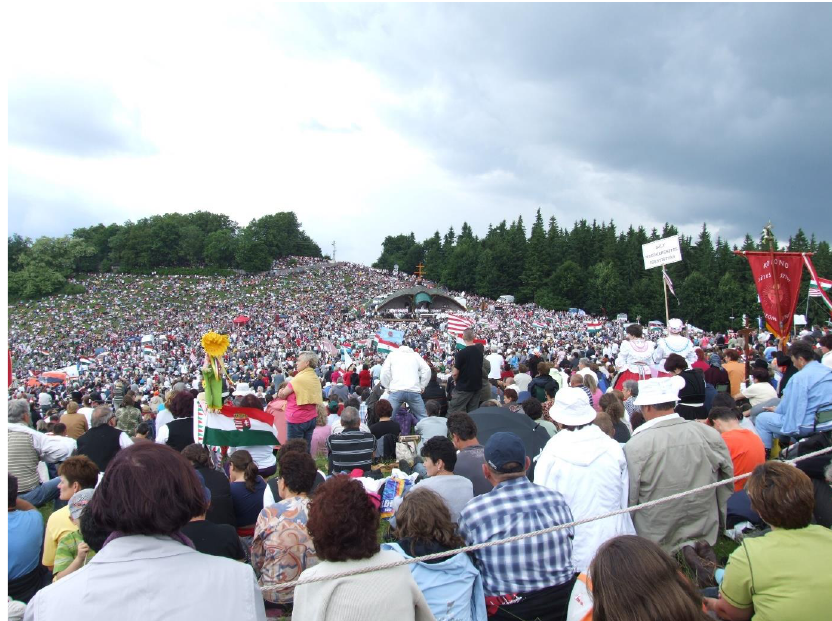
Figure 5. Open- air Pentecostal Catholic Mass in Şumuleu Ciuc (east Transylvania, Romania), the most important religious ensemble of the Hungarian ethnic minority in Romania in 2011.